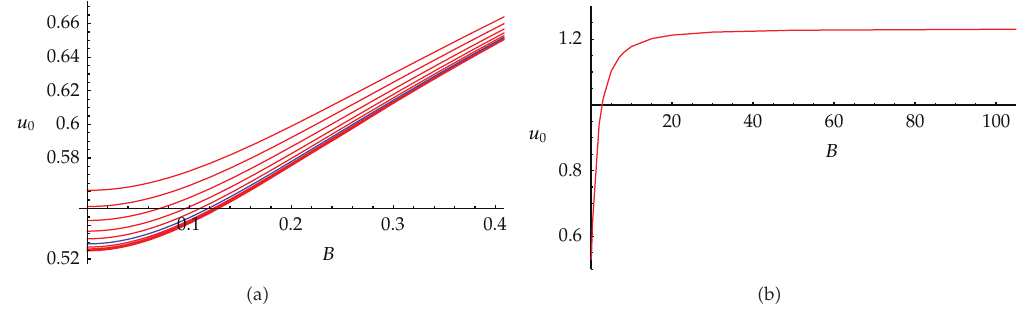
Figure 11: Relation between u 0 and external magnetic field B of the vacuum for (cid:3) a (cid:4) the temperature T (cid:8) 0 . 02–0.15, the upper lines have higher temperatures, (cid:3) b (cid:4) u 0 saturates to the approximate value of 1.23 at large field for all temperatures (cid:3) only T (cid:8) 0 . 10 curve is shown here (cid:4)